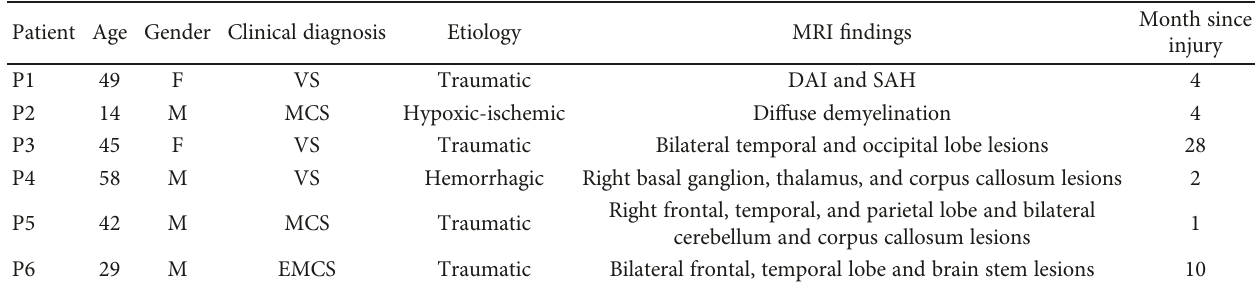
Table 1: Clinical data of patients with